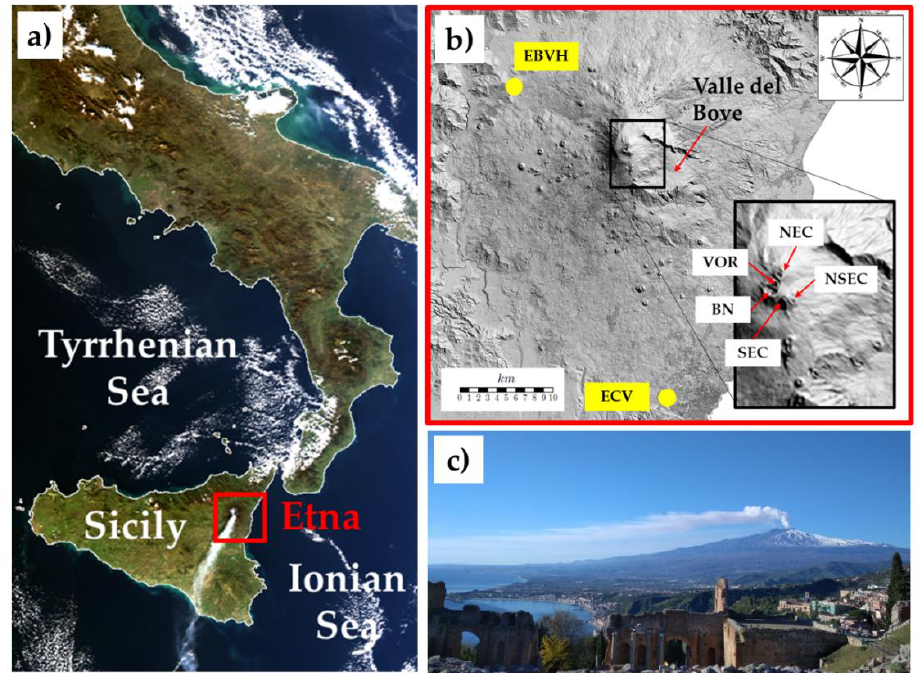
Figure 1. ( a ) Image of southern Italy collected from the MODIS satellite sensor on board the Terra/Aqua NASA satellite the 27 December 2018 at 12:20 UTC. ( b ) Map of Etna volcano with indication of the ground-based visible cameras (yellow points). In the zoom, the main active craters are indicated: Voragine (VOR), Bocca Nuova (BN), North East Crater (NEC), South East Crater (SEC) and New SEC (NSEC). ( c ) Etna activities of 27 December 2018 as seen from Taormina. Images modified from Corradini et al., 2020.